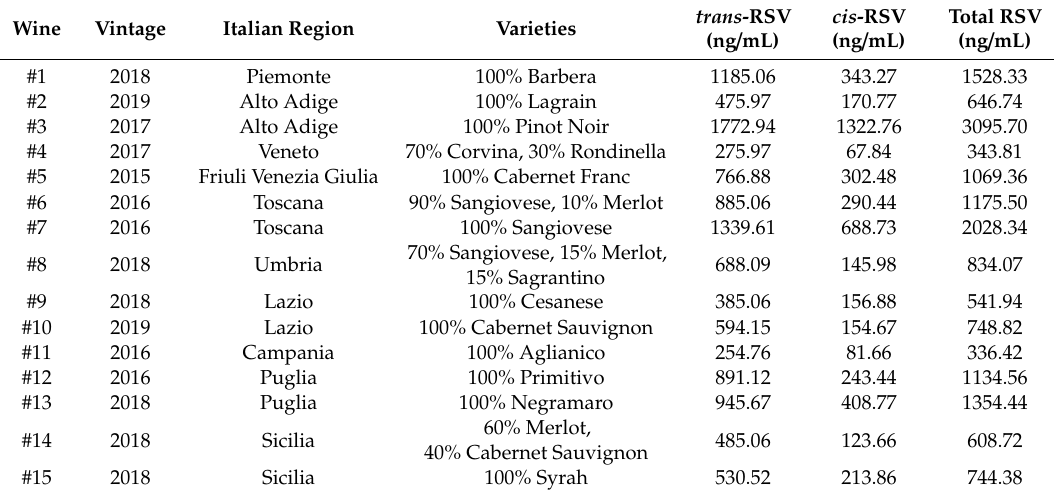
Table 2. trans - and cis -resveratrol content in a selection of Italian red wines (values are the mean of two